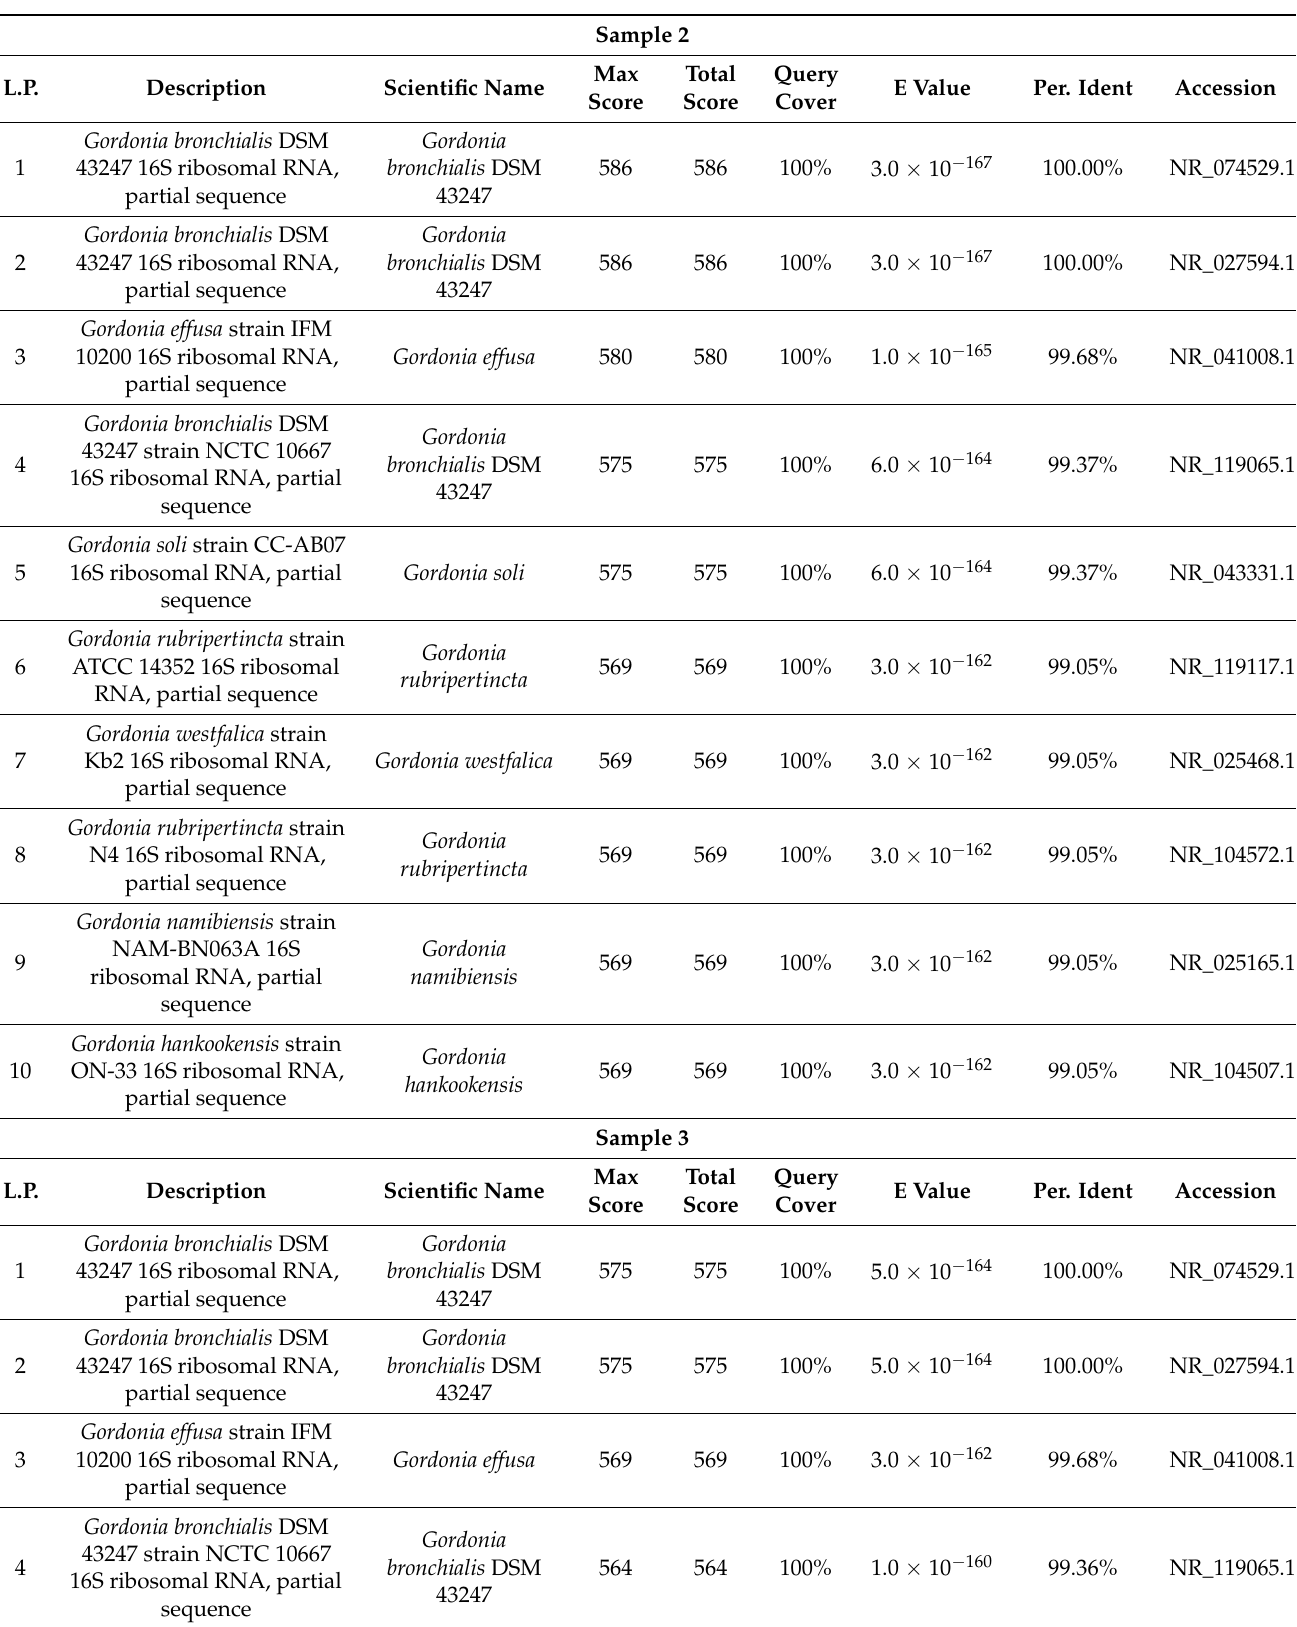
Table 1. The identified species comparison to 16s ribosomal RNA database (Bacteria and Archaea) with Megablast (Optimize for highly similar sequences) in two of four samples of the analyzed PCR